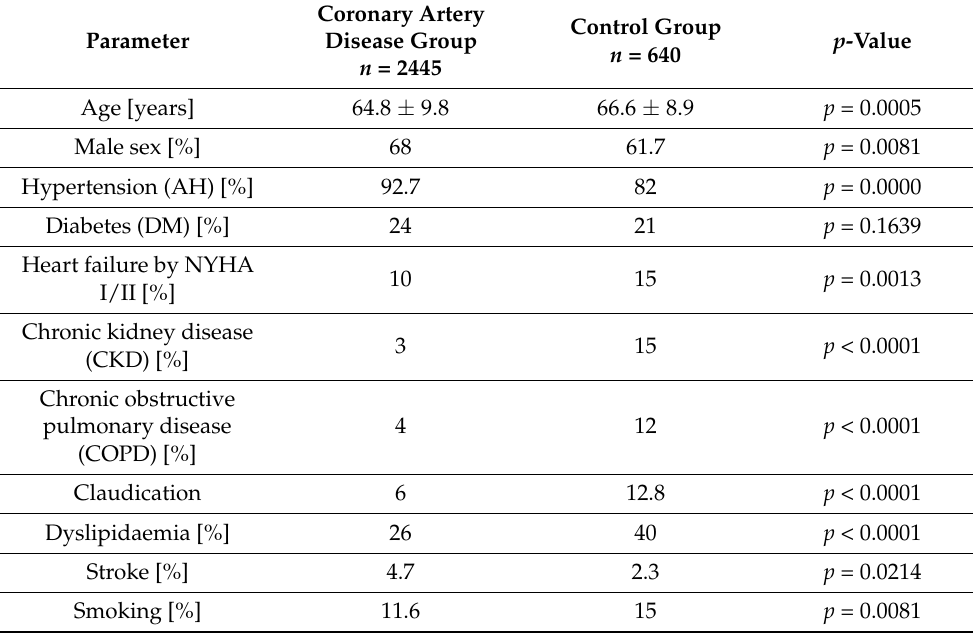
Table 1. Characteristics of the studied group.